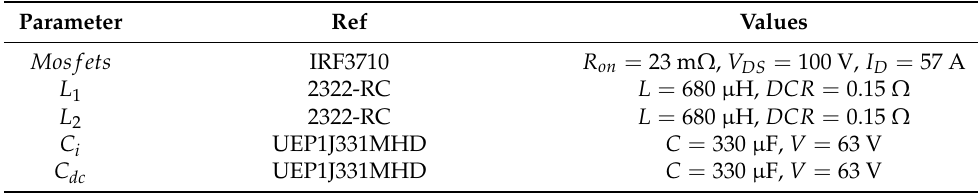
Table 2. Electronic devices selected for the Sepic/Zeta